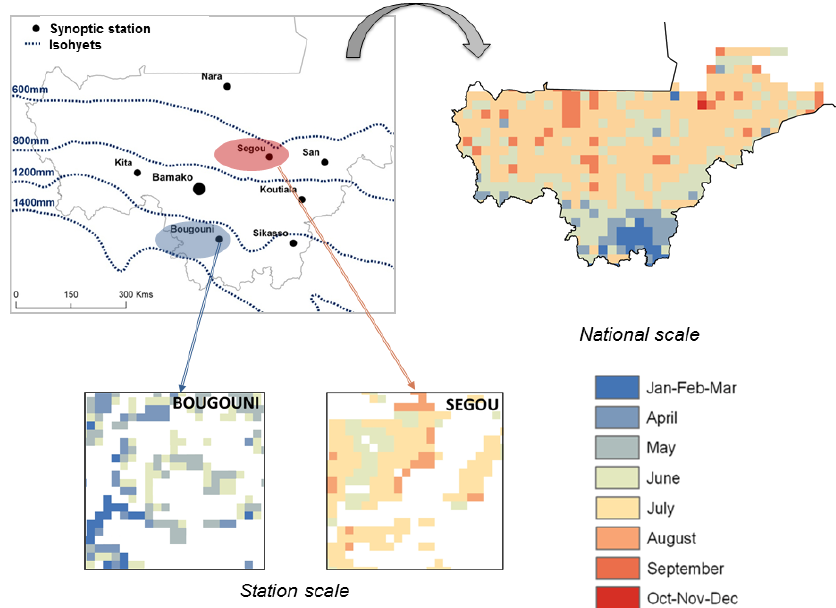
Figure 3. An example of start-of-season extraction on a national scale (averaged on a 20 × 20 km grid) and Bougouni- and Segou-station scale (defined by a 10 × 10 km polygon) and masked using a 2007 crop map